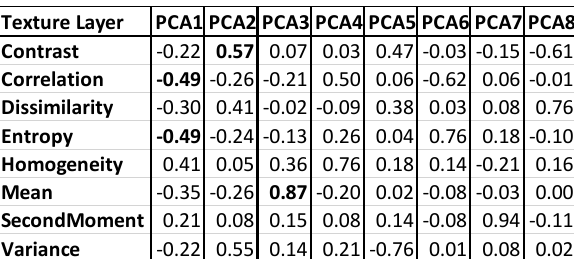
Figure 2: Study Flowchart